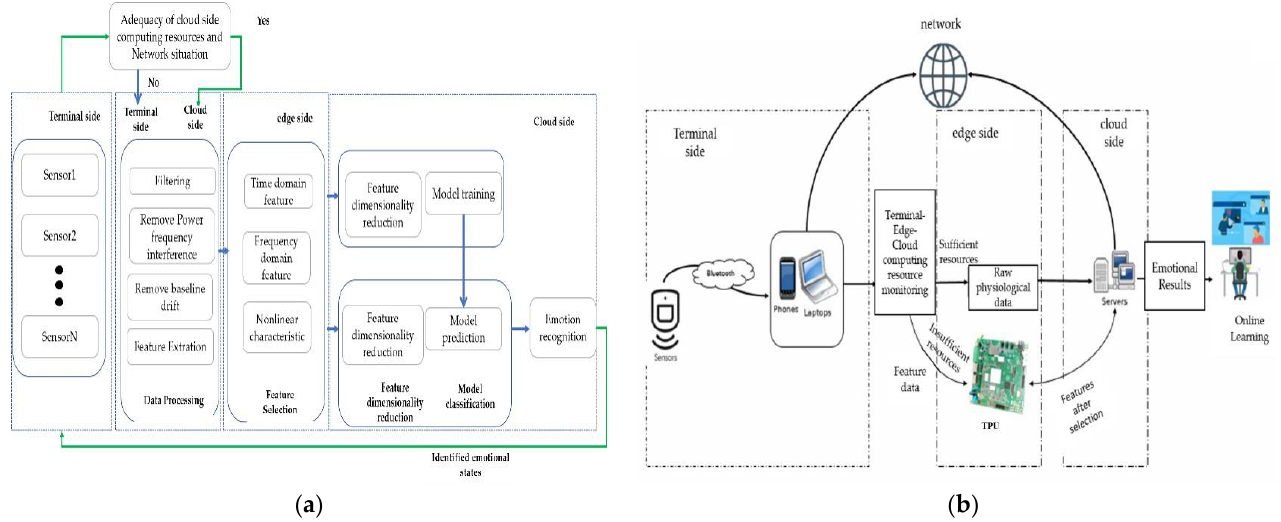
Figure 4. ( a ) Novel Affective computing Collaboration Architecture ( b ) Novel Computing Architec- ture Data Flow.